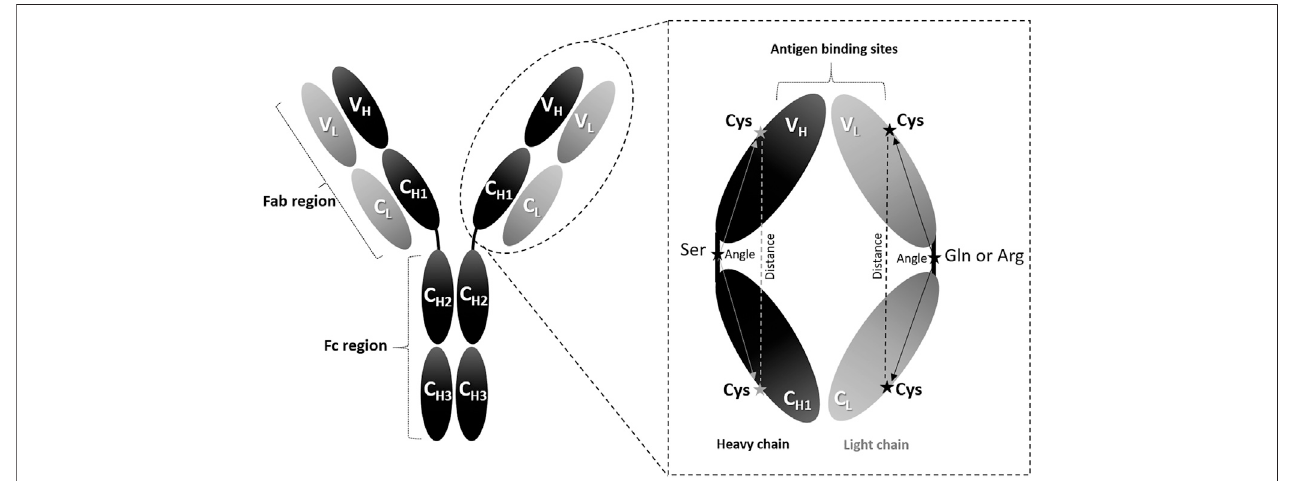
FIGURE1| Anglemeasurements.TheIgGantibodycanbedividedintothreefragments:twoFabregionsandoneFcregion.TheenlargedFabregionillustratesthe amino acid positions used to calculate the domain orientational changes. The selected amino acids are denoted as Cys: cysteine, Ser: serine, Gln: glutamine (in λ light chains), and Arg: arginine (in K light chains).